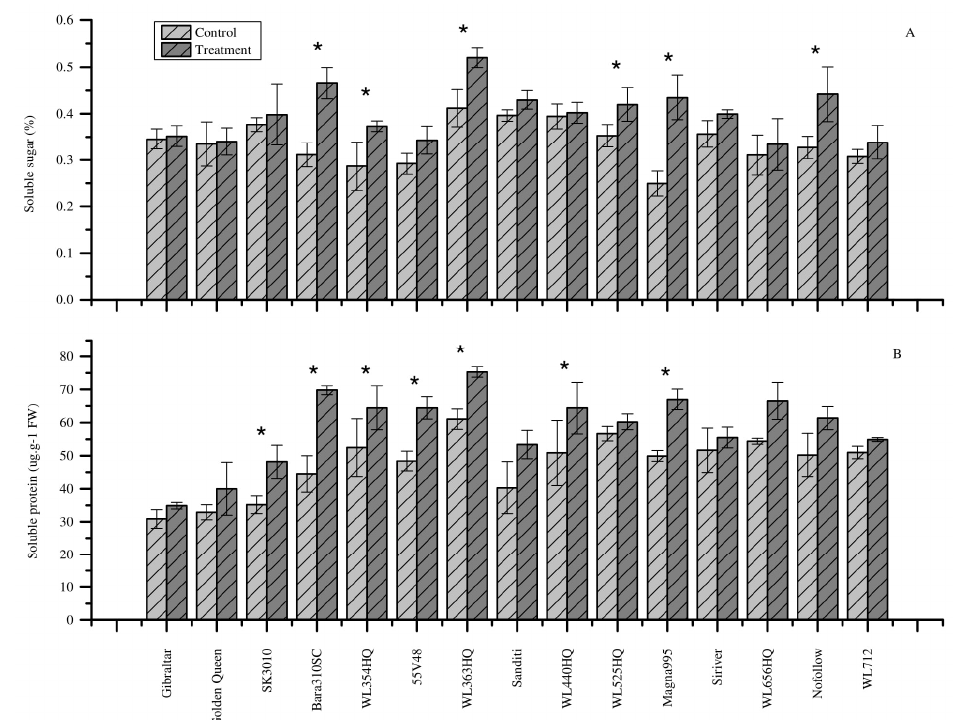
Figure 3. Effect of heat stress on soluble sugar and soluble protein content. ( A ) Soluble sugar content. ( B ) Soluble protein content. Each bar represents the mean ( n = 5) and the error bar indicates the standard deviation. Asterisks indicate statistical significant differences between control and treatment plant ( p < 0.05 ), independent sample t-test.